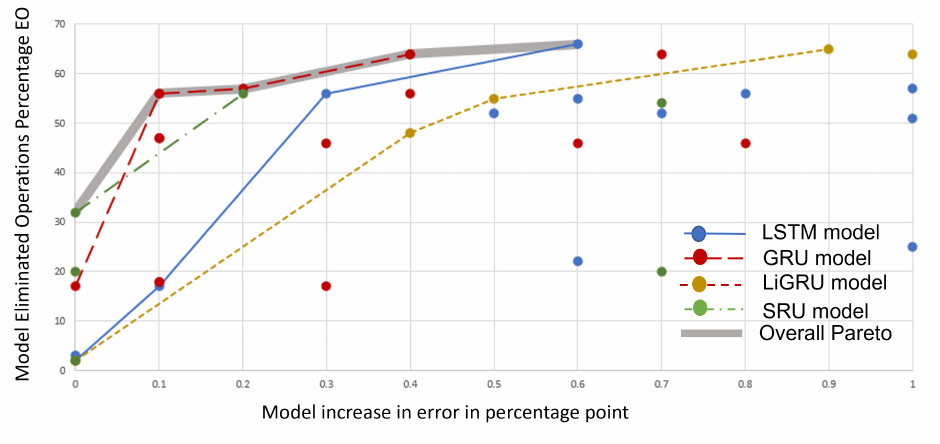
Figure 6. Eliminated operations plot. For each model, the eliminated operations (EO) percentages are plotted against the increase in error compared to each model’s baseline error. The best solutions are connected in a line. The gray shadow highlights the best points among all